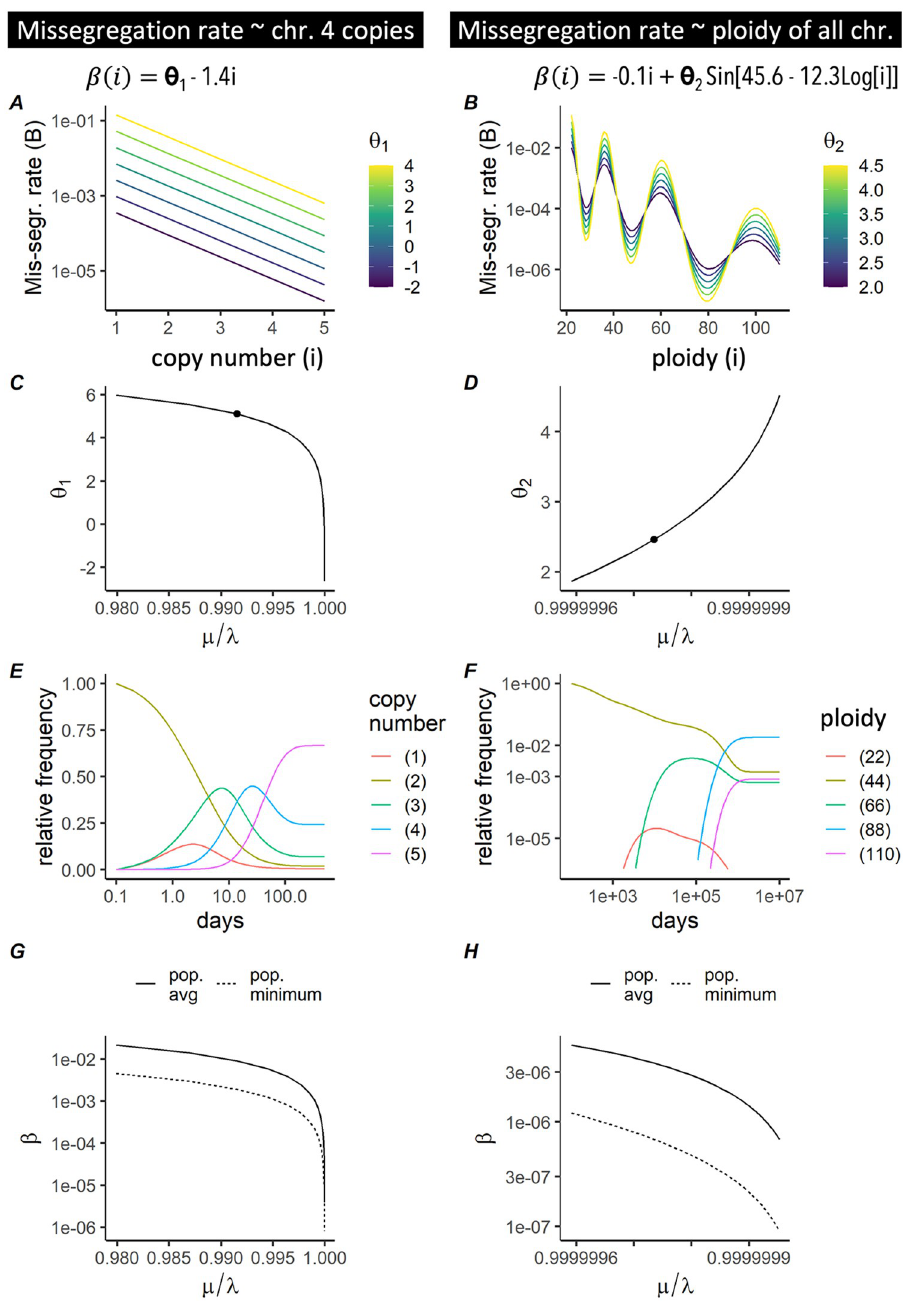
Fig 4. Predicting MIE when missegregation rates are heterogeneous. (A,B) Missegregation rate is modeled as a function of copy number or ploidy (x-axis), with color coded shape parameters θ 1 (A) and θ 2 (B). We consider the copy number of either chromosome 4 alone (A) or of all 22 autosomes in aggregate, i.e. ploidy (B). Varying θ 1 , θ 2 yields different missegregation rates ( β ). (C) Critical curve was obtained for (A) by finding ( y ; m ) for which the maximum 1 l eigenvalues of the Jacobian (Eq (10)) is 0. (D) Critical curve was obtained for (B) in the same manner as in (C), but here equations were solved for ( y ; m ). (E,F) We used the parameters highlighted in (C,D) to simulate missegregations 2 l until the karyotype composition reached a steady state. (G,H) The eigenvectors corresponding to the eigenvalues found in C/D are the steady state karyotype proportions. These are used in conjunction with the kernels in A/B to determine the population average and minimum missegregation rates (y-axis).